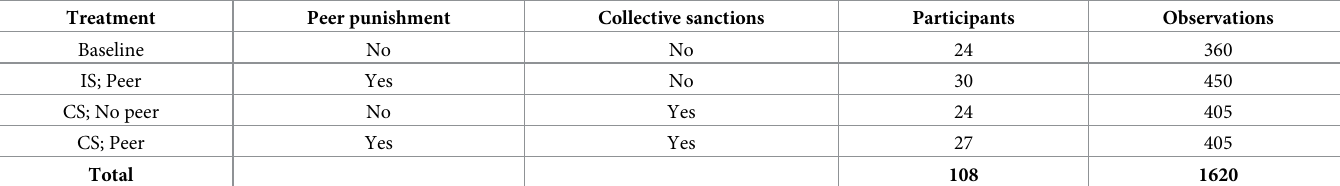
Table 2. Number of participants per treatment.